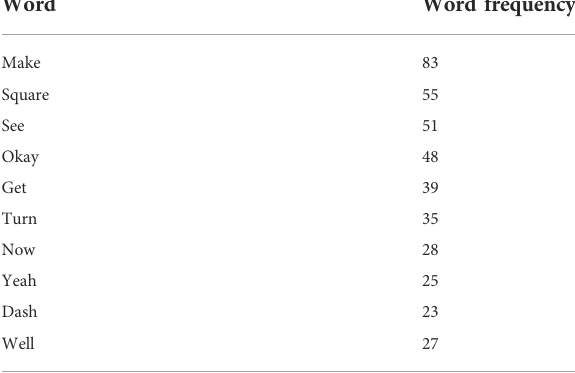
TABLE 3 Word frequency query results — participant 1